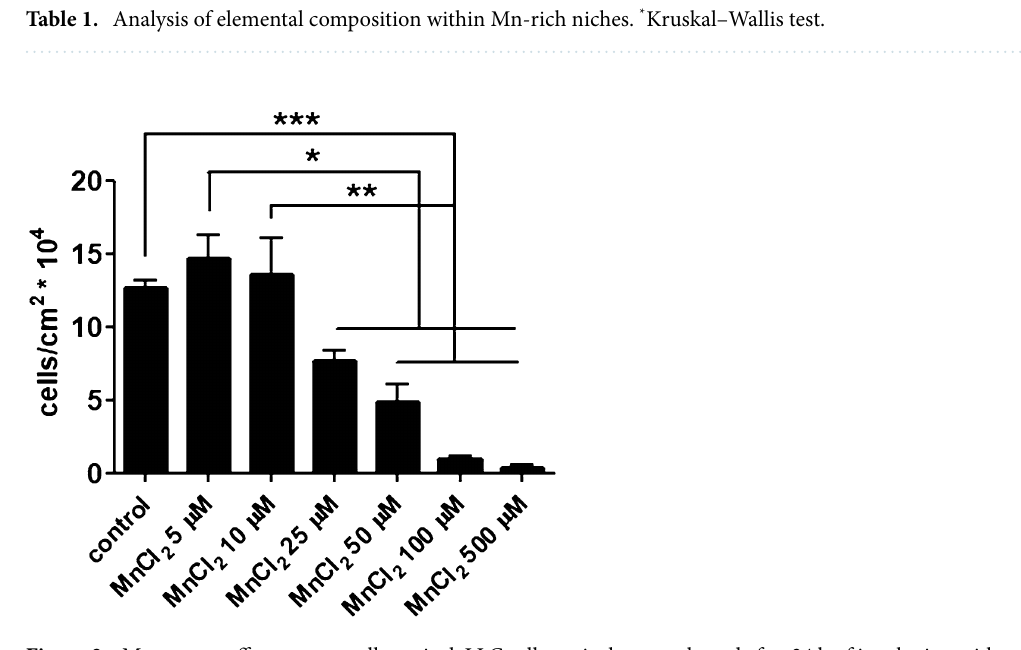
Figure 2. Manganese affects tumor cell survival. LLC cell survival was evaluated after 24 h of incubation with different